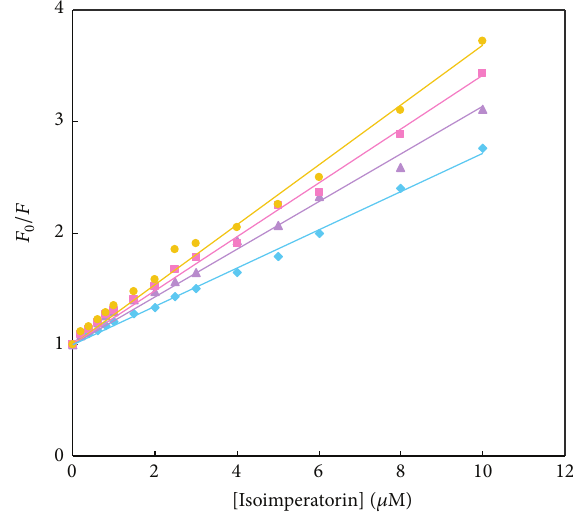
Figure 4: The Stern-Volmer plots for HSA fluorescence quenching by isoimperatorin at 298 ( ⧫ ), 303 ( 󳵳 ), 308 ( ◼ ), and 313 ( ∙ ) K. The final protein concentration in 50 mM phosphate, pH 7.5, was 3 𝜇 M. Based on “One-Sample Kolmogorov-Smirnov Test,”test distribution was